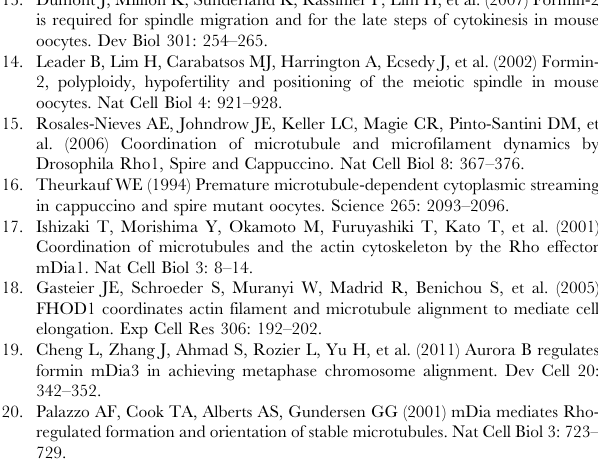
Figure S1 Effects of formin FH1–FH2 derivative expres- sion on stress fiber formation and microtubule organi- zation in HeLa cells. As in Figure 2, FH1–FH2 containing derivatives of the indicated formins were expressed by transient transfection in HeLa cells. Formin expression (left panel,) was detected by immunofluorescence by virtue of an encoded N- terminal myc epitope tag. F-actin (middle panel) was detected with phalloidin and microtubules were detected with an anti a -tubulin antibody (right panel). (TIF) Figure S2 Effects of formin FH1–FH2 derivative expres- sion on microtubule acetylation in fibroblasts. As in Figure 4, FH1–FH2 containing derivatives of the indicated formins were expressed by transient transfection in NIH 3T3 cells. Formin expression (left panel, red in merged image) was detected by immunofluorescence by virtue of the encoded N- terminal myc epitope tag. Acetylated microtubules were detected with an anti-acetylated a -tubulin antibody (middle panel, white in merged image). F-actin was detected with Alexa488-phalloidin (green, left panel).